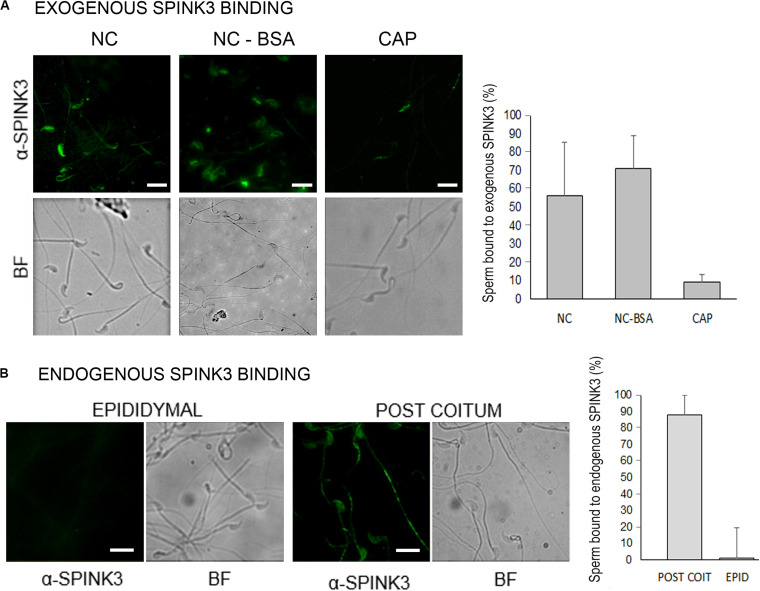
Distribution of SPINK3 on capacitated and non-capacitated sperm. (A) Caudal sperm were incubated in non-capacitating (NC) or capacitating (CAP) conditions and then treated with recombinant SPINK3 (13 μM, “exogenous SPINK3”) for 15 min, washed and fixed. As a control of BSA blocking effect, a NC + BSA condition was included. SPINK3 was immunodetected as detailed in Methods. (B) Sperm recovered from the uterus of synchronized females immediately after coitus or from the male epididymis (negative control of cells that were not in contact with seminal vesicle secretions) were fixed. Then, native SPINK3 (“endogenous SPINK3”) was immunodetected. For (A,B) left panel shows representative pseudocolor images and bright fields (BF), and right panel shows percentage of positive immunoreactive cells. Scale bar = 10 μM.